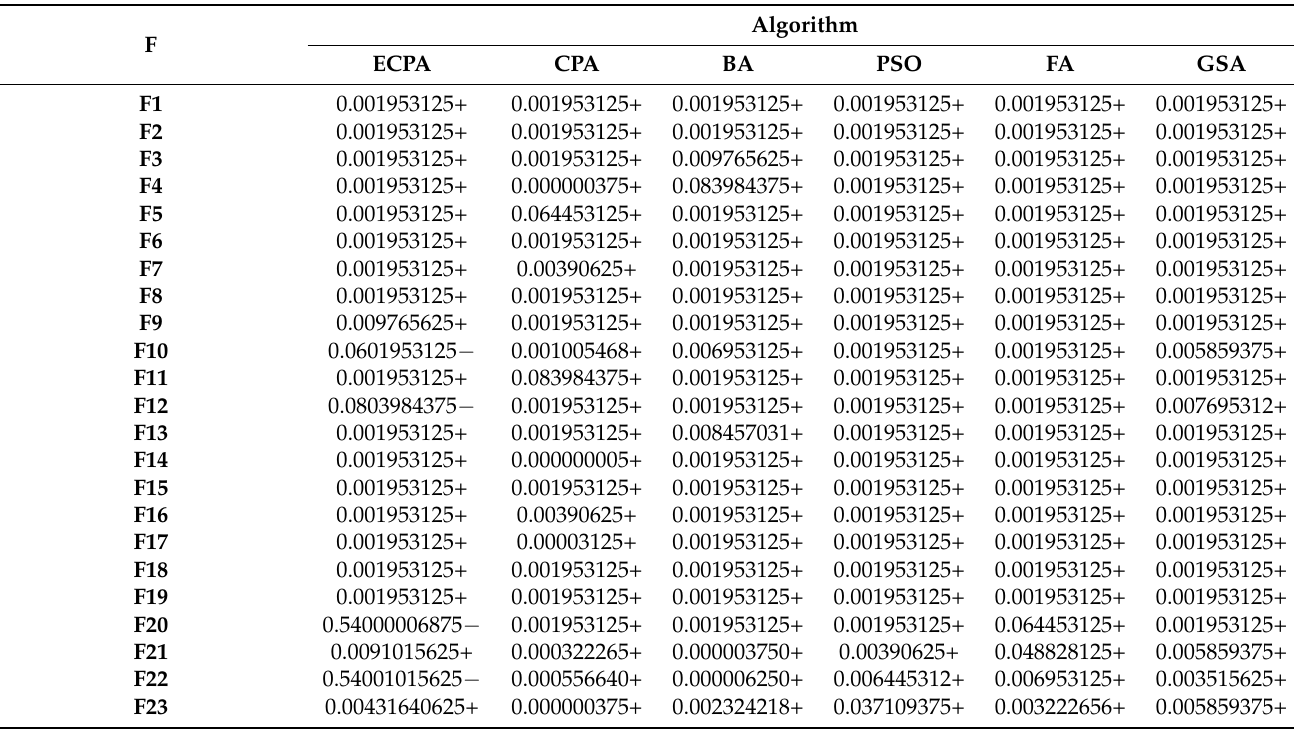
Table 4. Results of p -values for MLCPA and other